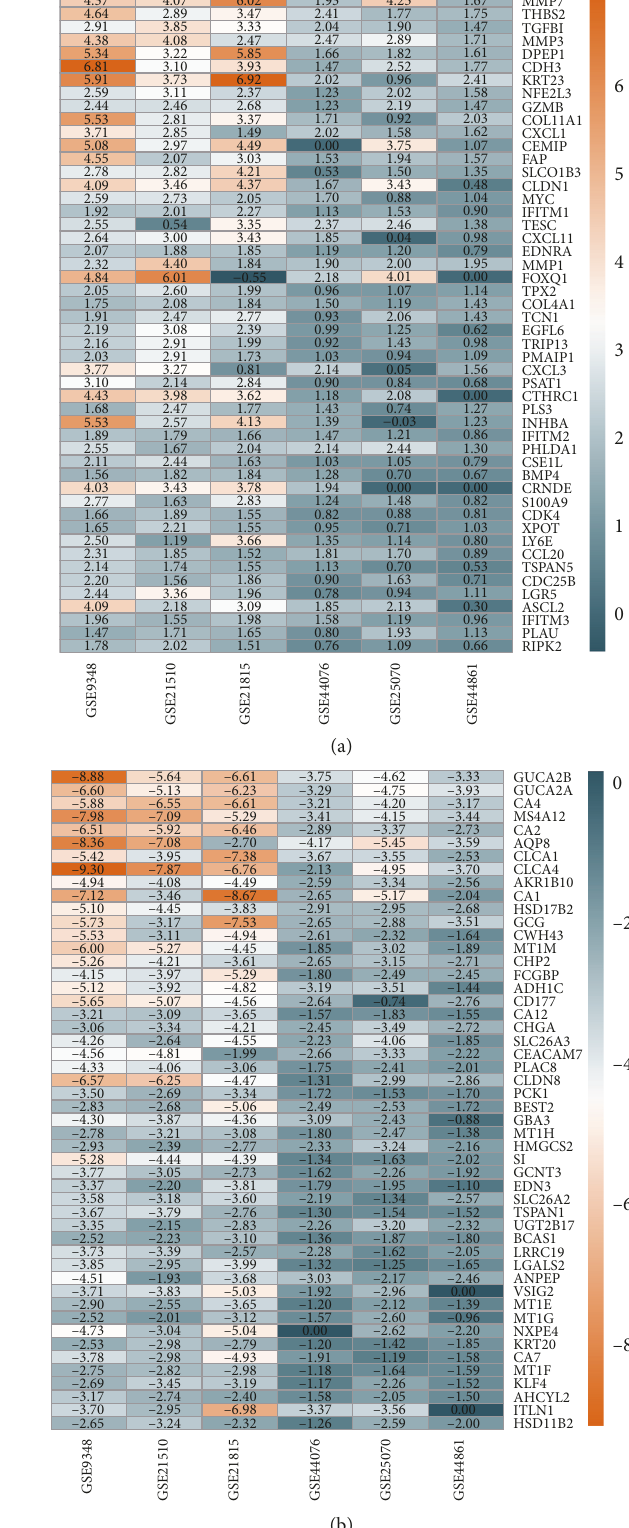
Figure 3: Top 50 robust DEGs identified in the six microarray data (i.e., GSE25070, GSE44076, GSE44861, GSE21510, GSE9348, and GSE21815) from the GEO database: (a) upregulated genes; (b)down- regulated genes. These genes were ranked by adjusted P